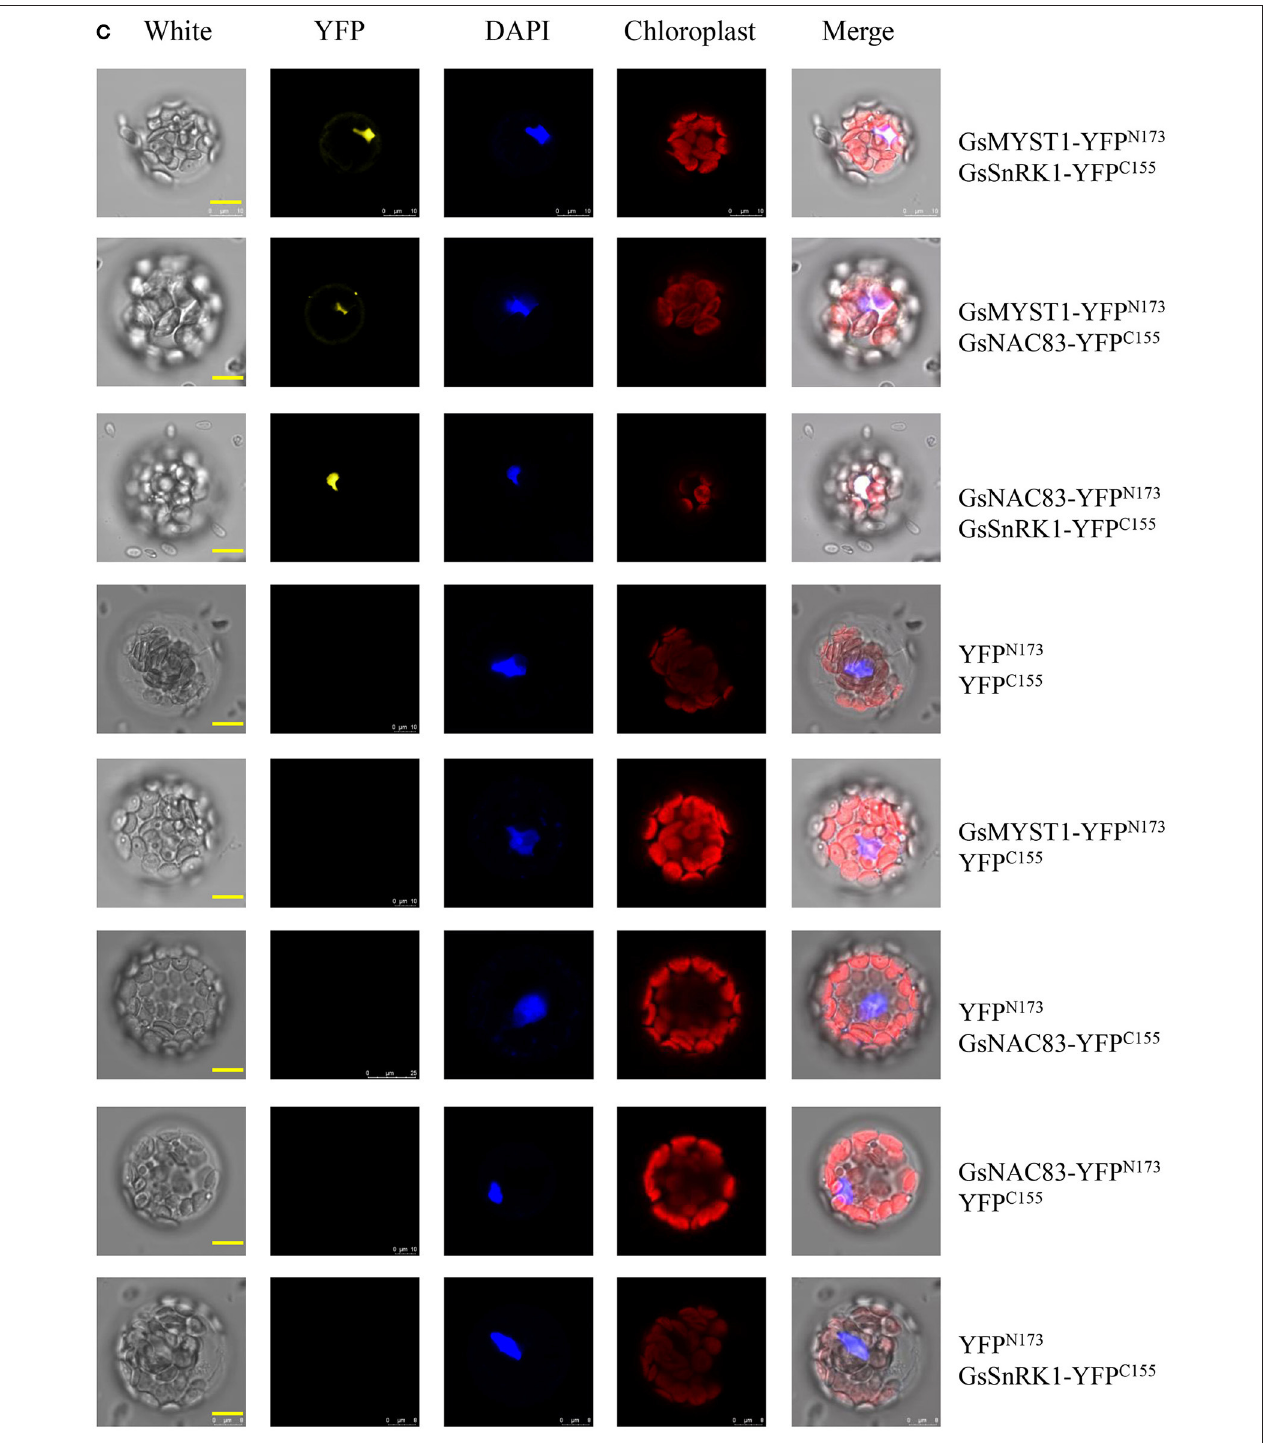
FIGURE 3 | Physical interaction of GsSnRK1, GsMYST1, and GsNAC83. (A) Yeast two-hybrid assays: GsSnRK1 , GsMYST1 , and GsNAC83 genes were cloned into AD or BD vectors. The resulted plasmids or the control vectors were cotransformed into Y2HGold yeast cells. The transformed clones were grown on the selective media with or without X-alpha-gal. (B) Co-immunoprecipitation assay: GsMYST1 , GsSnRK1 , and GsNAC83 genes were cloned into vectors with HA or Myc tag. The obtained plasmids were coexpressed in Arabidopsis protoplasts. The total proteins were extracted for co-immunoprecipitation assays using the indicated antibodies. (C) BiFC assay: GsMYST1 , GsSnRK1 , and GsNAC83 genes were cloned into the vectors with YFP N173 or YFP C155 sequence. The resulted plasmids were transiently coexpressed in Arabidopsis protoplasts for 16h. The YFP signals were observed under a confocal microscope. Each representative figure is shown from three biological